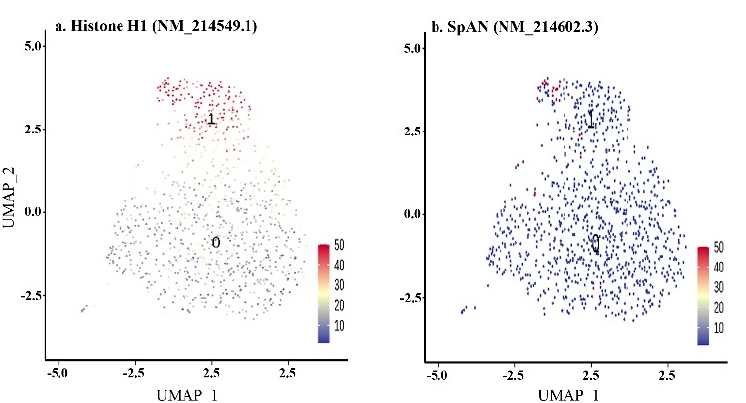
Figure 5. Feature plot of 64—cell stage. Cluster 0 corresponds to the vegetal pole of the embryo, cluster 1 to the vegetal pole. Each point corresponds to the single cell, and its color marks the level of either H1 ( a ) or SpAN (b) gene expression.